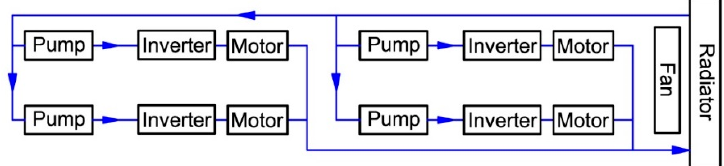
Figure 1. Simplified schematic of the thermal management system.